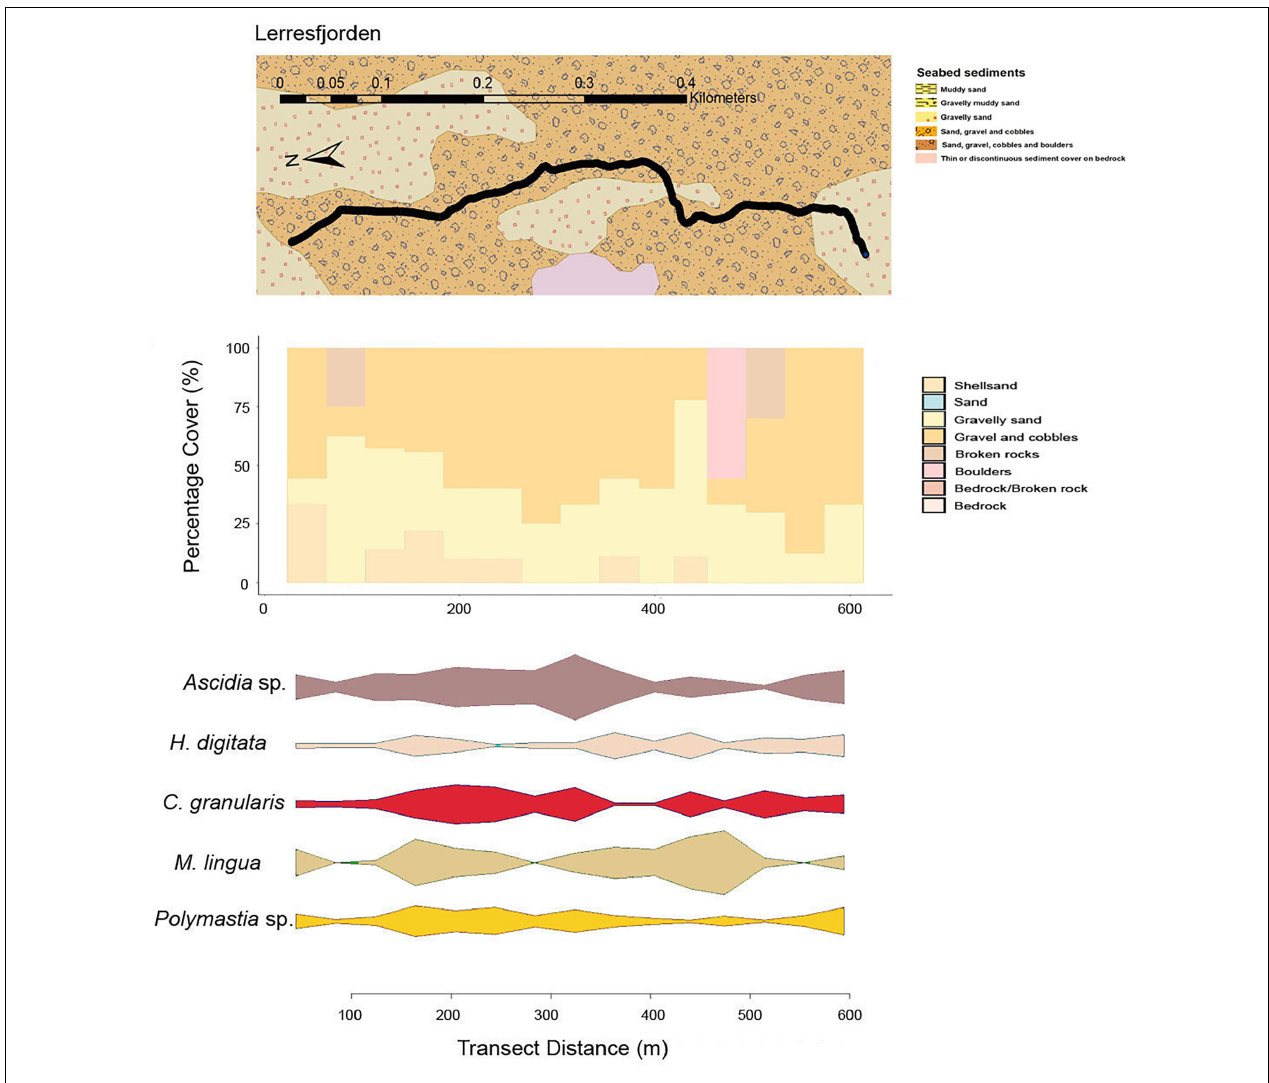
FIGURE 3 | Mixed-substrate seabed characteristics, sequential bar plots of the percentage coverage of the primary substrate types from the camera transects and densities of key epifaunal species or genus at the transect sites in